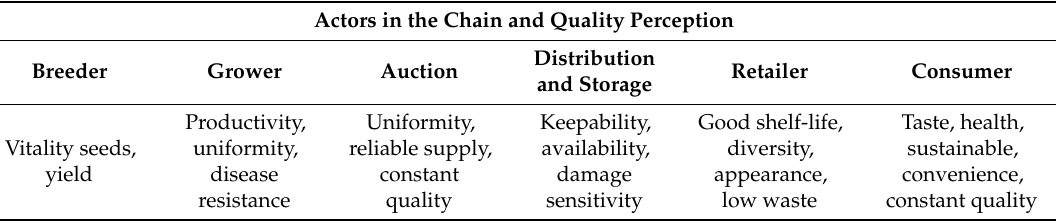
Table 1. Actors in the chain and quality